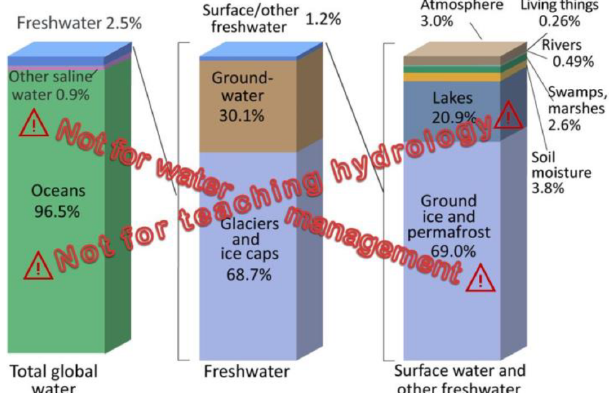
Figure 13. Typical depiction of water on Earth (source of the background image without the stamp: